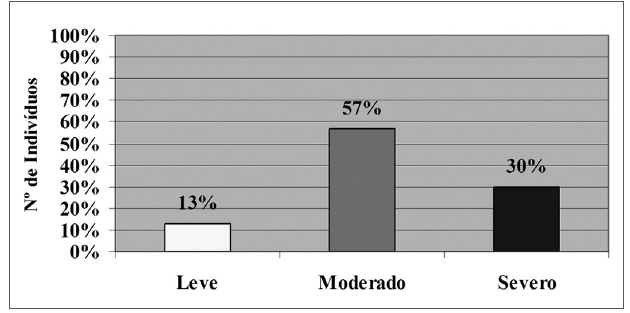
Figura 2. Resultados obtidos em relação à média de nota atribuída à variável severidade do zumbido, no grupo pesquisa (N=30). Os resultados quantitativos obtidos na comparação dos valores médios das latências dos componentes